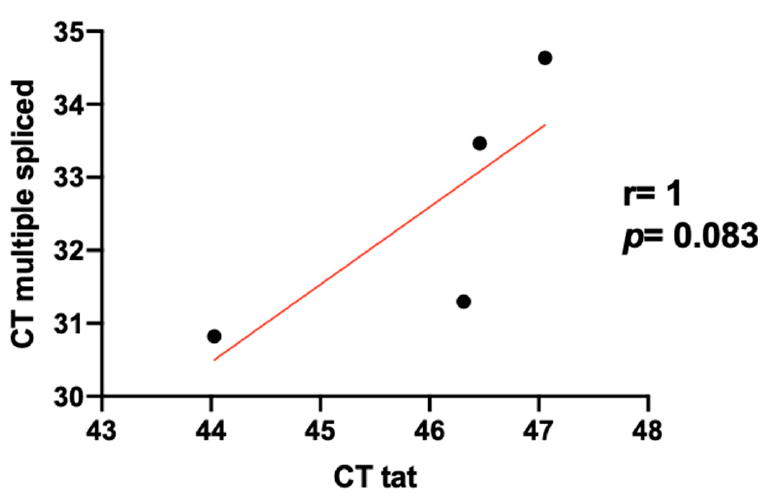
Figure 2. Pearson’s correlation between level of expression of Tat and multiple spliced transcripts. Expression of Tat mRNA level in PBMCs infected in vitro with HIV NL4.3 strain (0.2 µ g p24 / µ L) was analyzed by qPCR. Non-infected PBMCs were used as a negative control and β -actin was used as a housekeeping gene.